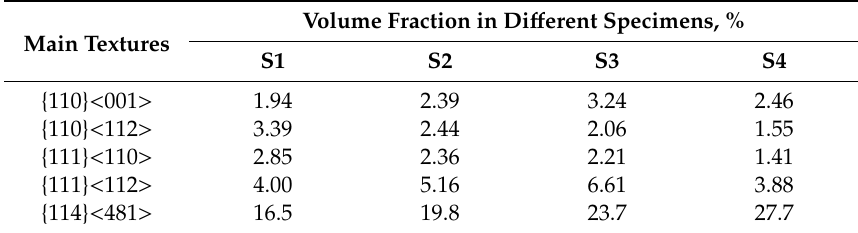
Figure 8. Orientation image maps (OIM) of several main components in primary recrystallized sheets: ( a ) Nb-free, ( b ) Nb-0.005 wt%, ( c ) Nb-0.009 wt%, ( d ) Nb-0.025 wt%. Table 2. Volume fraction of main texture in primary recrystallized sheet. (Deviation angle < 15 ◦